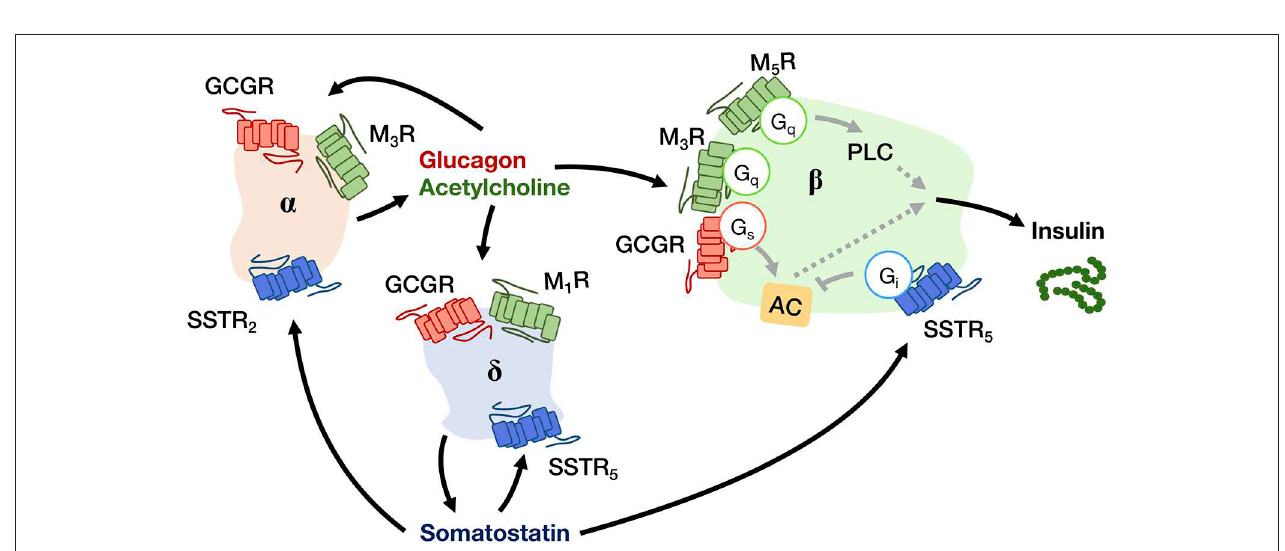
FIGURE 2 | A schematic diagram showing the autocrine and paracrine interactions between pancreatic α -, β -, and δ -cells that regulate the insulin output. Glucagon and acetylcholine from α -cell (beige), and somatostatin from δ -cell (blue) are stimulatory and inhibitory signals for hormone secretion, respectively, that can act in both autocrine and paracrine manners via their receptors (GCGR for glucagon; M 1 R, M 3 R, and M 5 R for acetylcholine; SSTR 2 and SSTR 5 for somatostatin). The insulin output from β -cell (green) is adjusted by an integration of paracrine signals from both α - and δ -cells within the